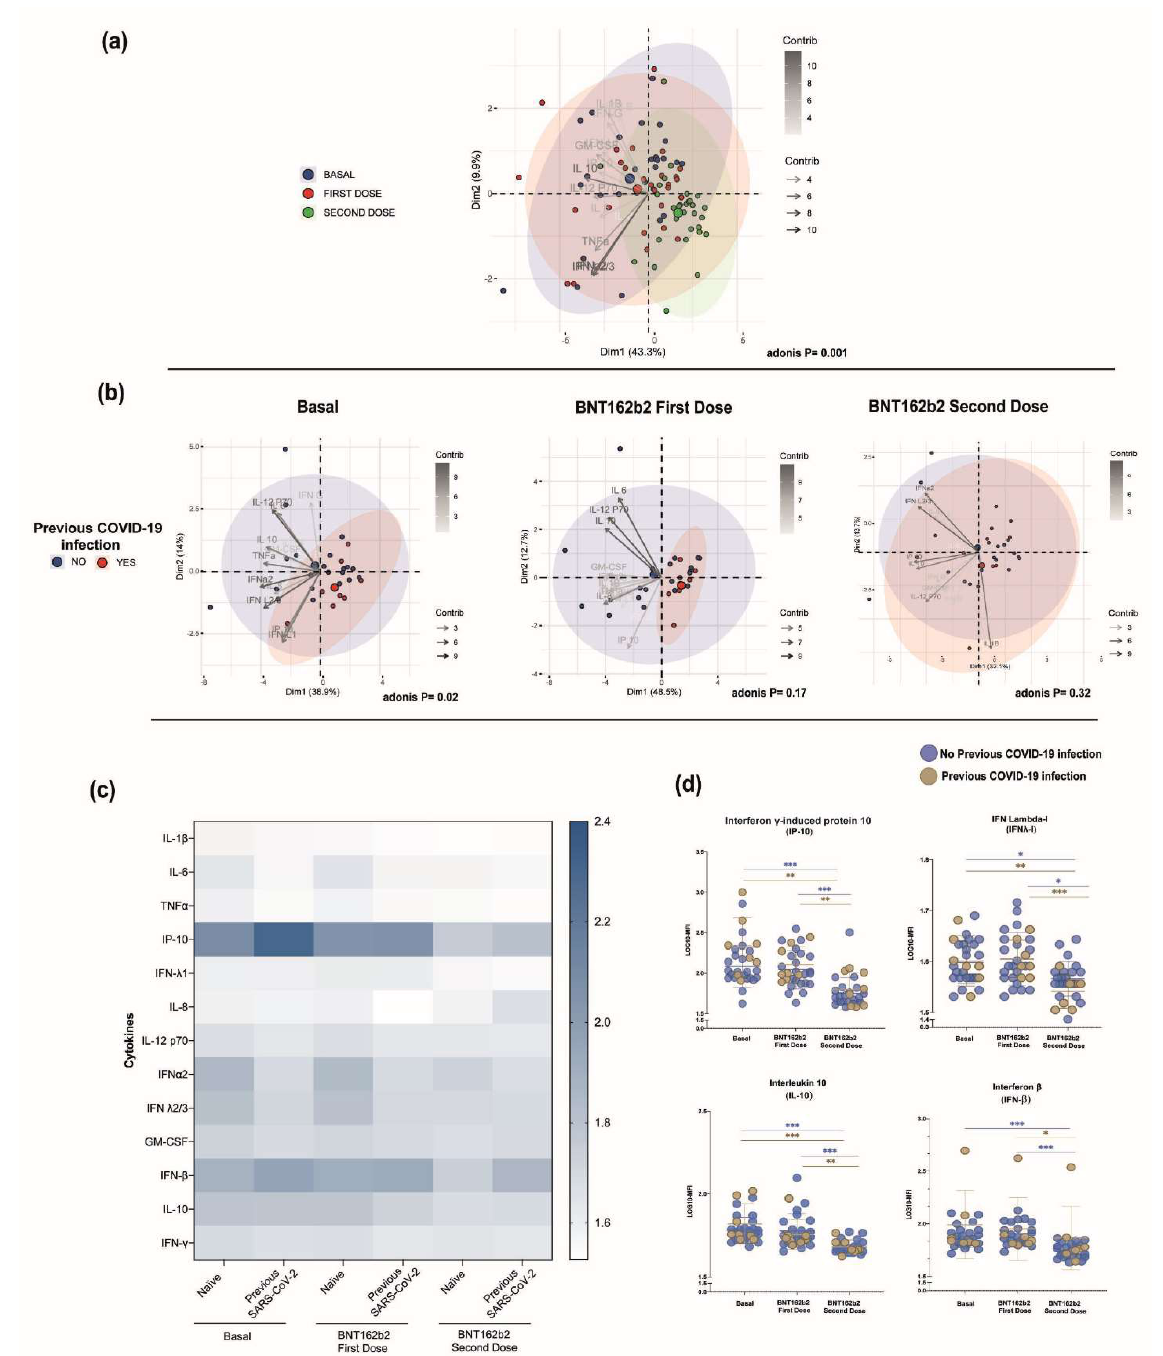
Figure 4. ( a ) PCA biplot showing the PCA analysis of serum cytokine profile compared over time and ( b ) a previous SARS-CoV-2 infection vs. naïve participants; plots were generated according to each time point. Principal component scores for components 1 (PC1) and 2 (PC2) were plotted for each group and time point. Samples were then colored by group; previous SARS-CoV-2 infection (red) and naive (blue) illustrate the sample clustering. Arrows are drawn based on the percentage contribution of variables to each component. ( c ) Heatmap of the cytokine MFI log values compared over time and a previous SARS-CoV-2 infection. ( d ) Individual cytokine values of the representative cytokines from the analyzed participants. Differences between groups were determined by Mann–Whitney U test with an α ≤ 0.05; * p = 0.05–0.01, ** p = 0.01–0.001, *** p <